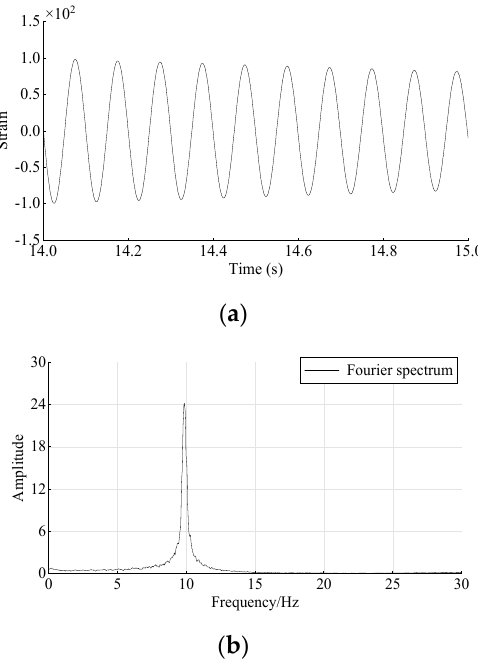
Element Number ×10 -3 Figure 11. Identified results in the intact model. 5.3. Damage Identification Measured responses from strain gauges on hammer excitation of the beam are used in the damage identification. Figure 12a,b show the dynamic response at Node 23 in dam- age scenario 2 in the time domain and frequency domain, respectively. The sampling fre- quency is set to 1 kHz, and the data of 1 s during free vibration are extracted for damage identification. Accordingly, the passband frequency of the bandpass filter is set to 8 Hz and 11 Hz, and the stopband frequency is set to 6 Hz and 13 Hz. Figure 13 shows the convergence curves of the damage factor and RE in the process of FE model updating. Table 4 shows the number of iterations and time consumption for convergence ( − ≤ × 6 RE 1.0 10 ) under different damage scenarios. It can be seen that the damage factor of the preset damage elements can converge near the expected value in the